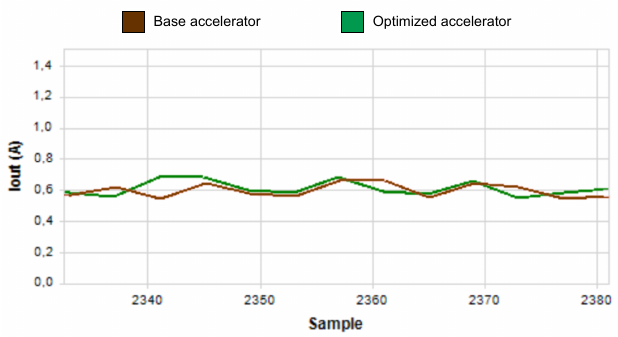
Figure 7. Current of the V DDQ power supply rail for the DDR4